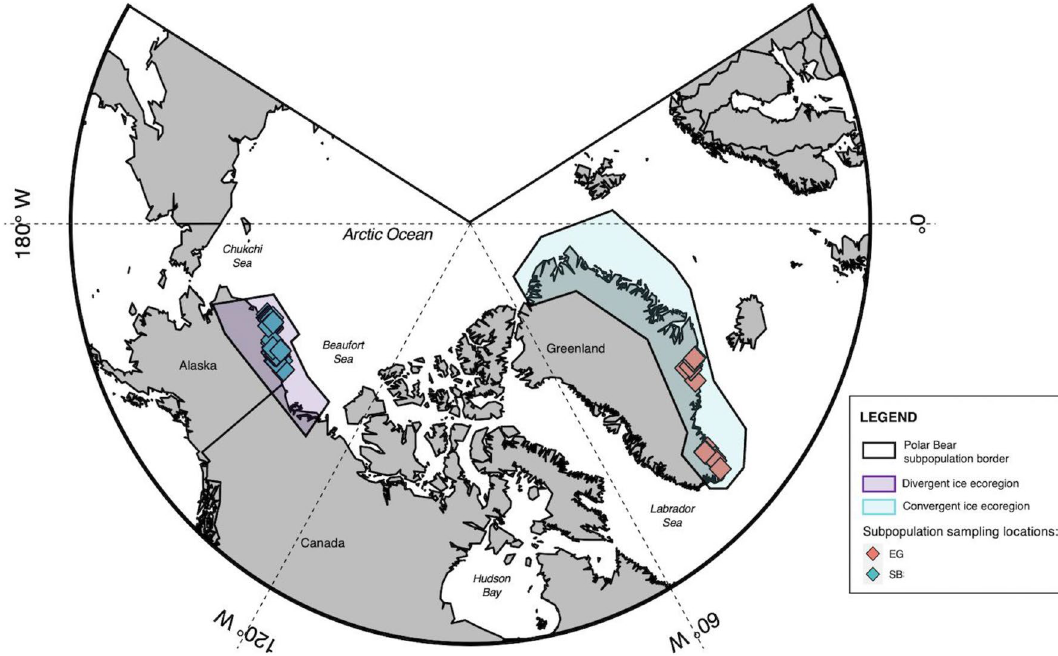
Figure 1. Map of sampling locations for the two polar bear subpopulations in this study. The East Greenland (EG) subpopulation is distributed along the east Greenland shoreline and occurs in a convergent ice ecoregion (blue), while the Southern Beaufort Sea (SB) polar bear subpopulation is distributed along the northern shore of Alaska and Canada and occurs in a divergent ice ecoregion (purple). Map made with R Studio using the PlotSvalbard package in R (V.